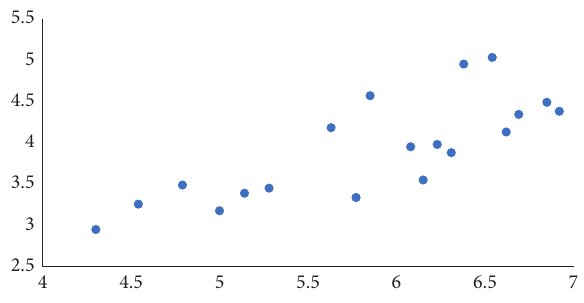
Figure 4: Plane distribution of design variables. Table 2: Data points and response values.